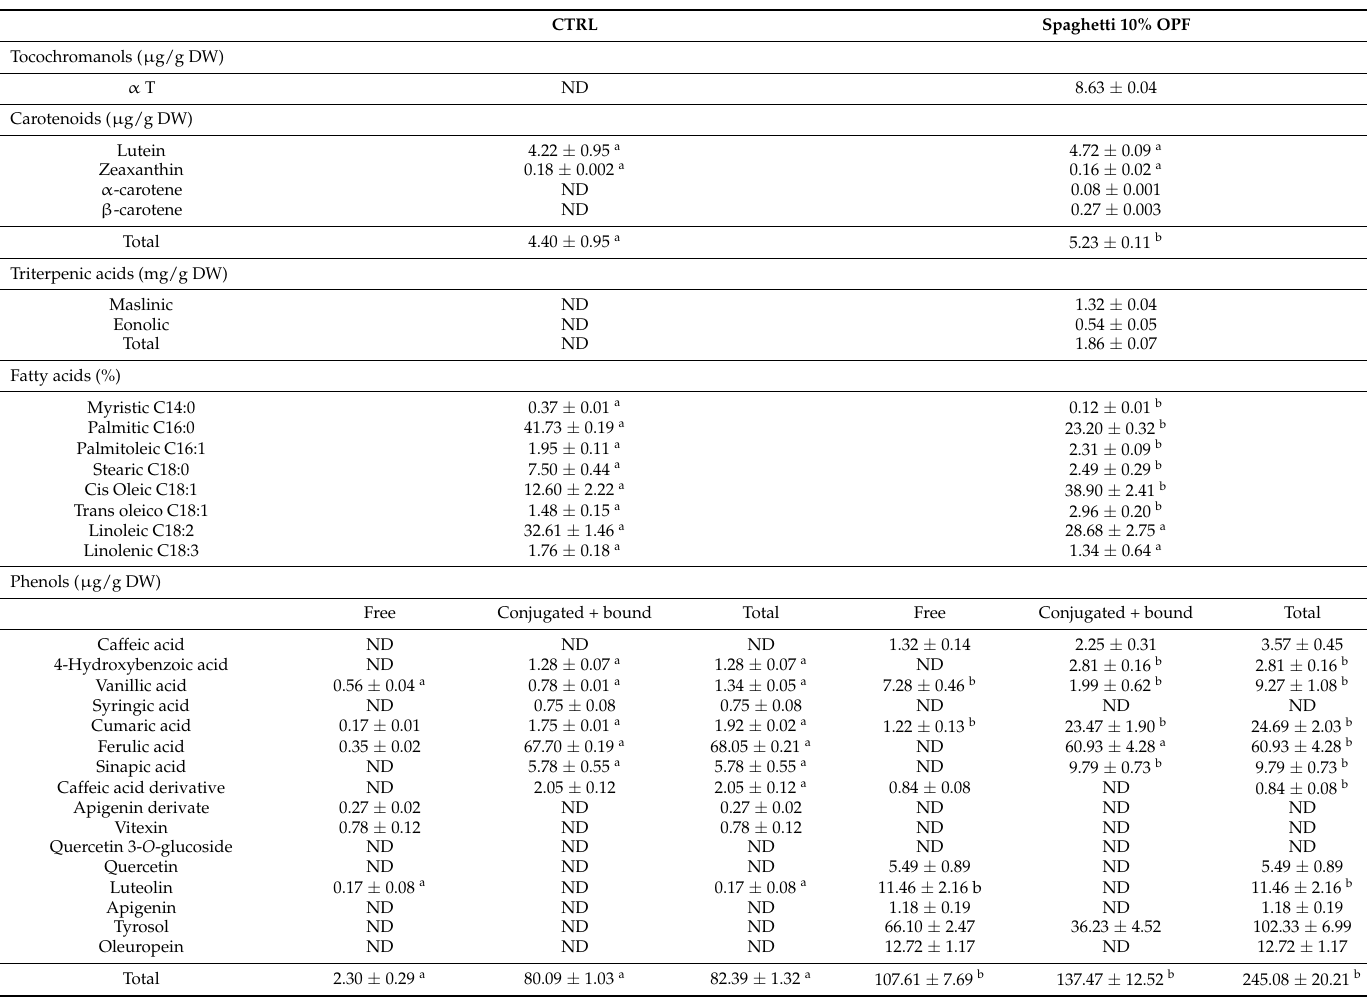
Table 5. Tocochromanols, carotenoids, fatty acids and phenolic composition of control spaghetti (CTRL) and spaghetti enriched with 10% olive paste flour (OPF). Different letters indicate differences between the CTRL and OPF ( p < 0.05). ND: not